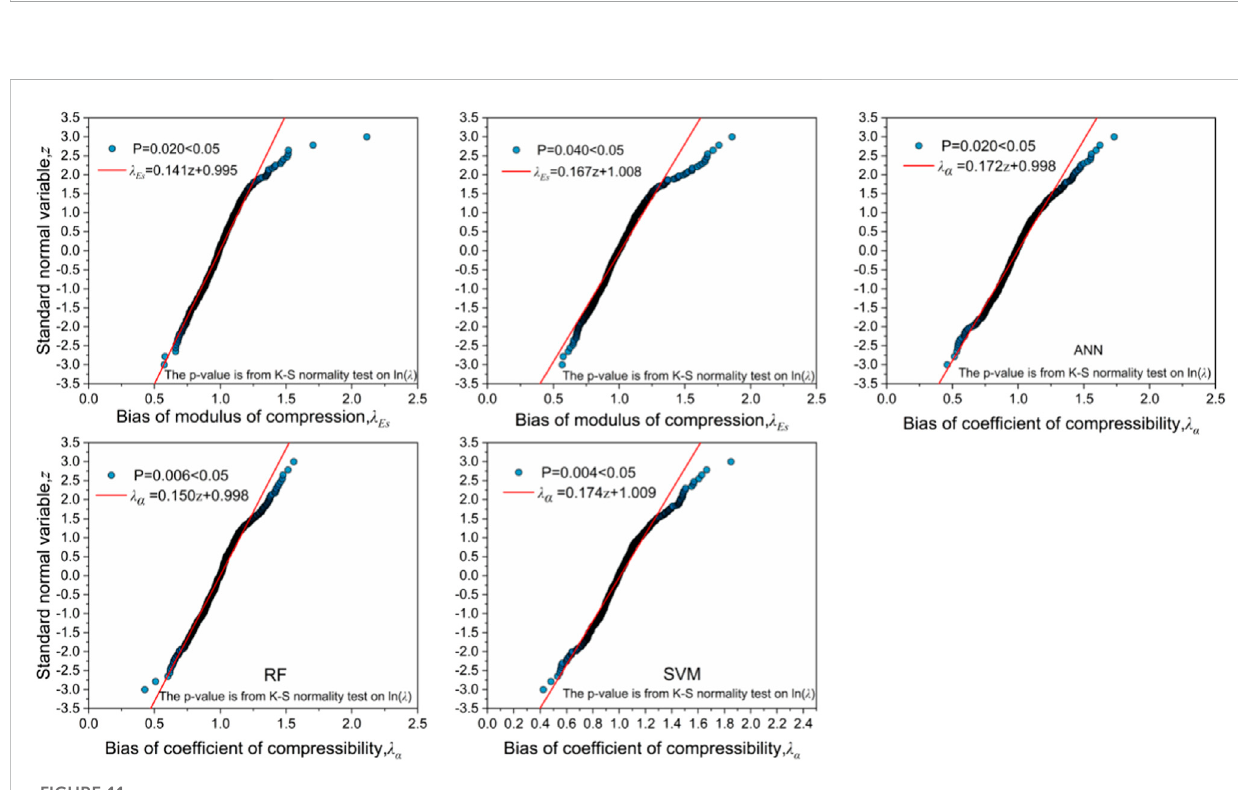
Fit-to-tail technique applied to the tail distributions of fi ve model